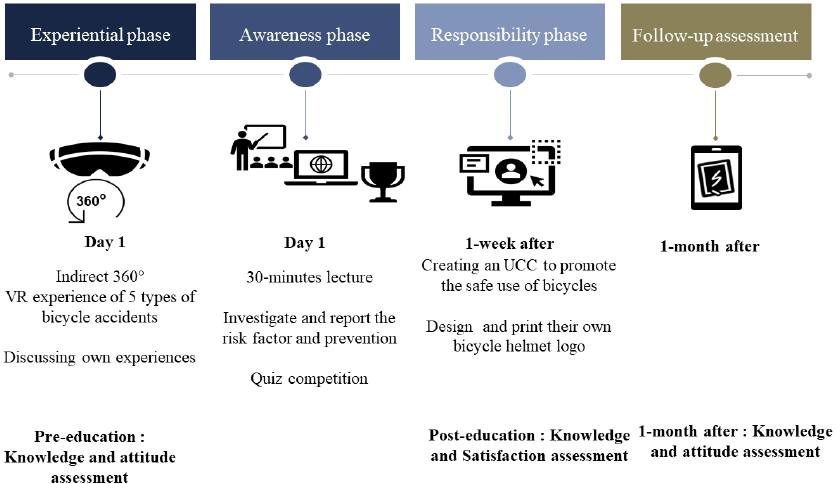
Figure 1. The bicycle injury prevention program based on the Activated Health Education (AHE) theory implemented by the community center.